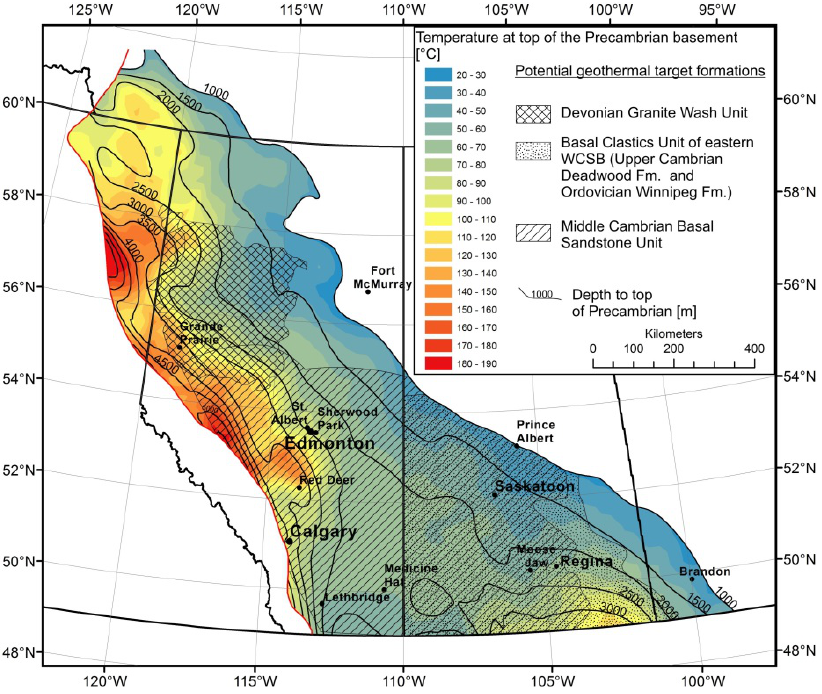
Figure 5. Temperature at the top of the Precambrian basement with potential geothermal target formations; formations outline from Trotter [25] (Granite Wash Unit), from Slind et al. [26] and Dixon [24] (Basal Clastics), and from Pugh [27,28] (Cambrian Basal Sandstone Unit BSU).